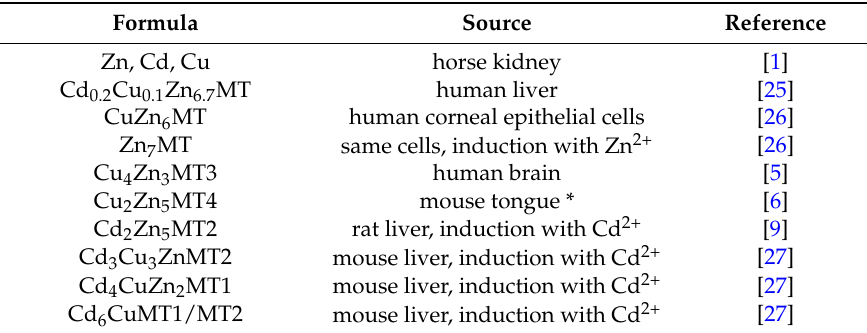
Table 1. Metal composition of native mammalian metallothioneins